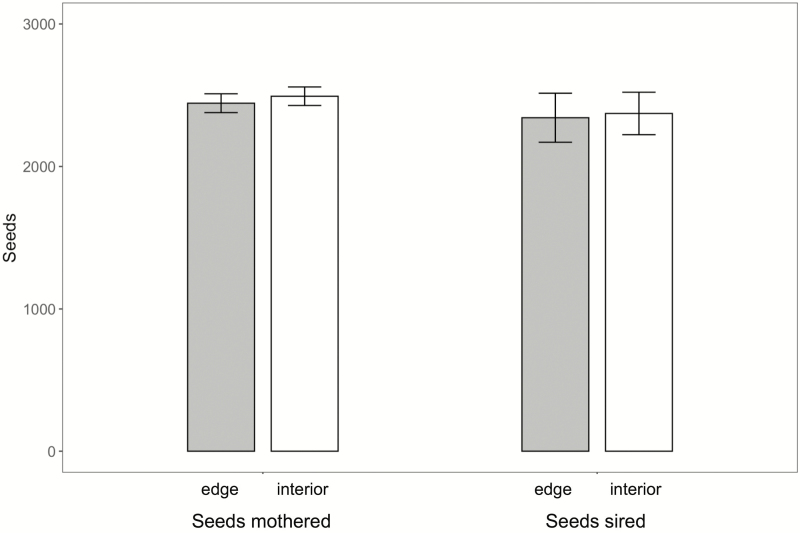
Mean number of seeds (±1 SE) mothered on, or sired by, edge and interior plants. N per bar = 96 for edge and 100 for interior plants. The number of seeds sired is slightly lower than the number of seeds mothered due to the estimation error of paternity shares.